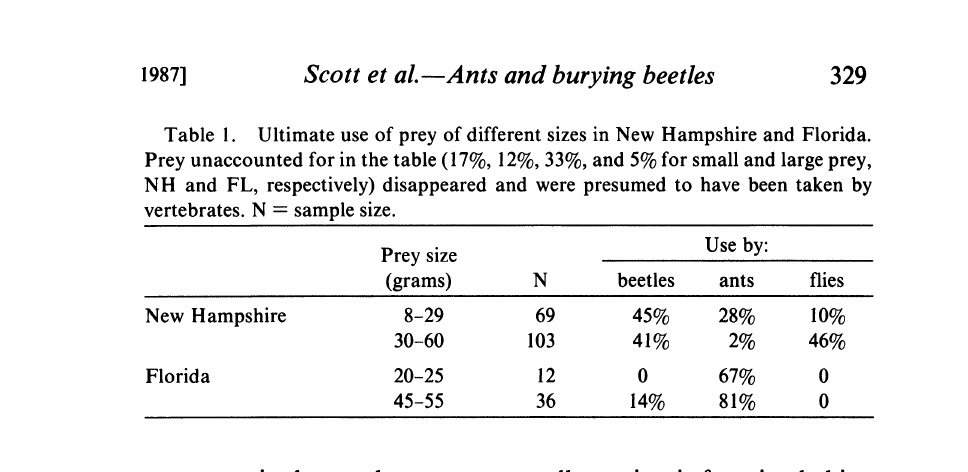
Table 1. Ultimate use of prey of different sizes in New Hampshire and Florida. Prey unaccounted for in the table (17%, 12%, 33%, and 5% for small and large prey, NH and FL, respectively) disappeared and were presumed to have been taken by vertebrates.